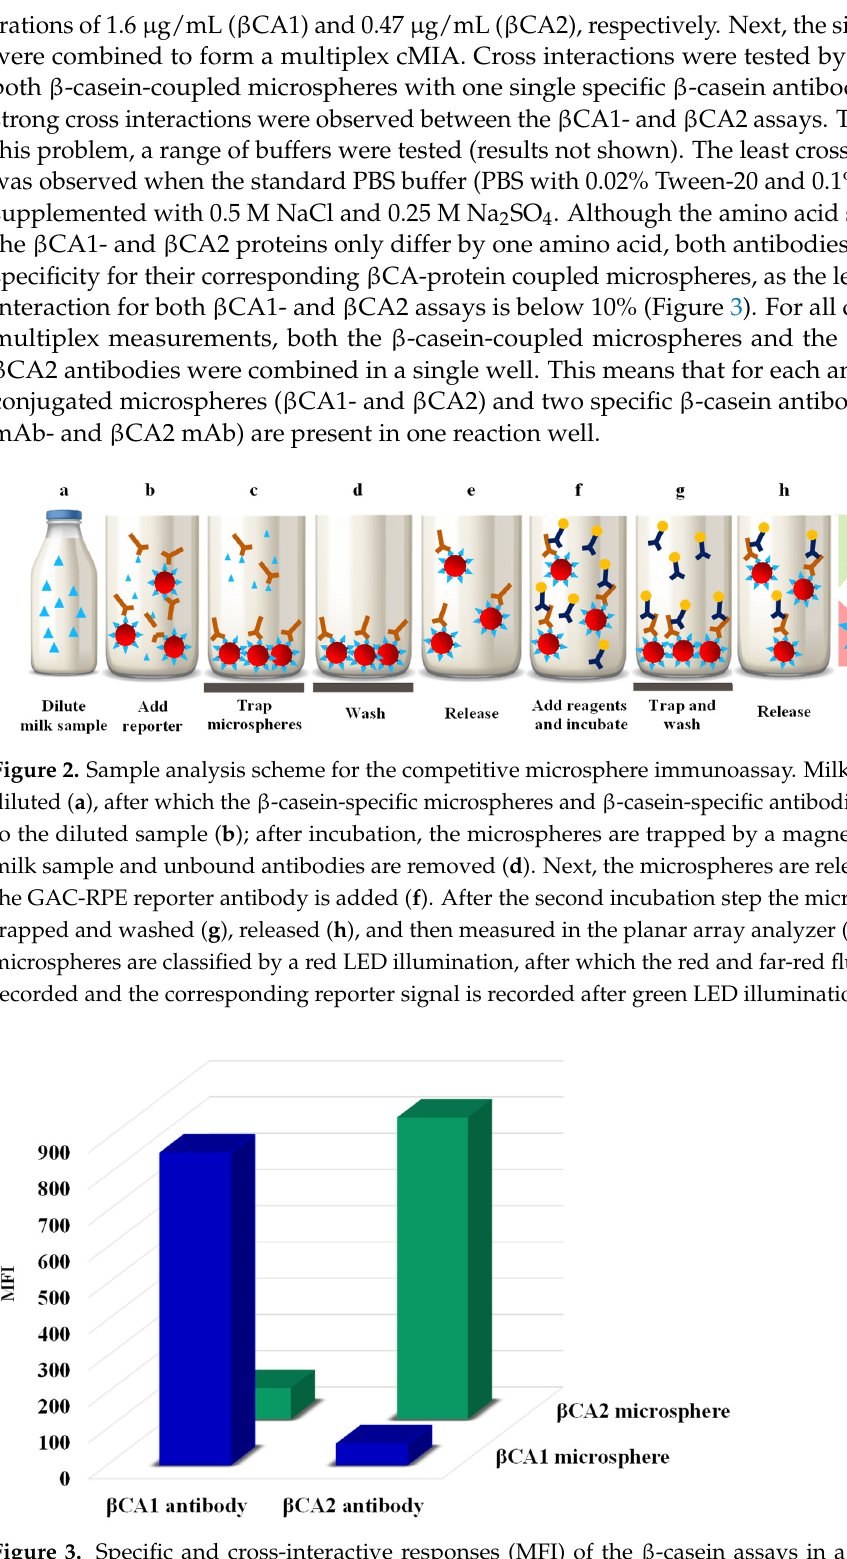
Figure 3. Specific and cross-interactive responses (MFI) of the β -casein assays in a competitive multiplex assay format where the multiplex microspheres are incubated with only a single antibody in the absence of milk samples. Blue bars are MFI values for β CA1 microspheres with β CA1- and β CA2 specific antibodies in buffered solution. Green bars are MFI values for β CA2 microspheres with β CA1- and β CA2 specific antibodies in buffered solution.